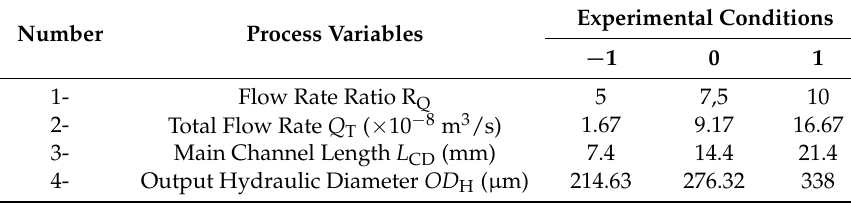
Table 3. Factorial experimental planning for simulations